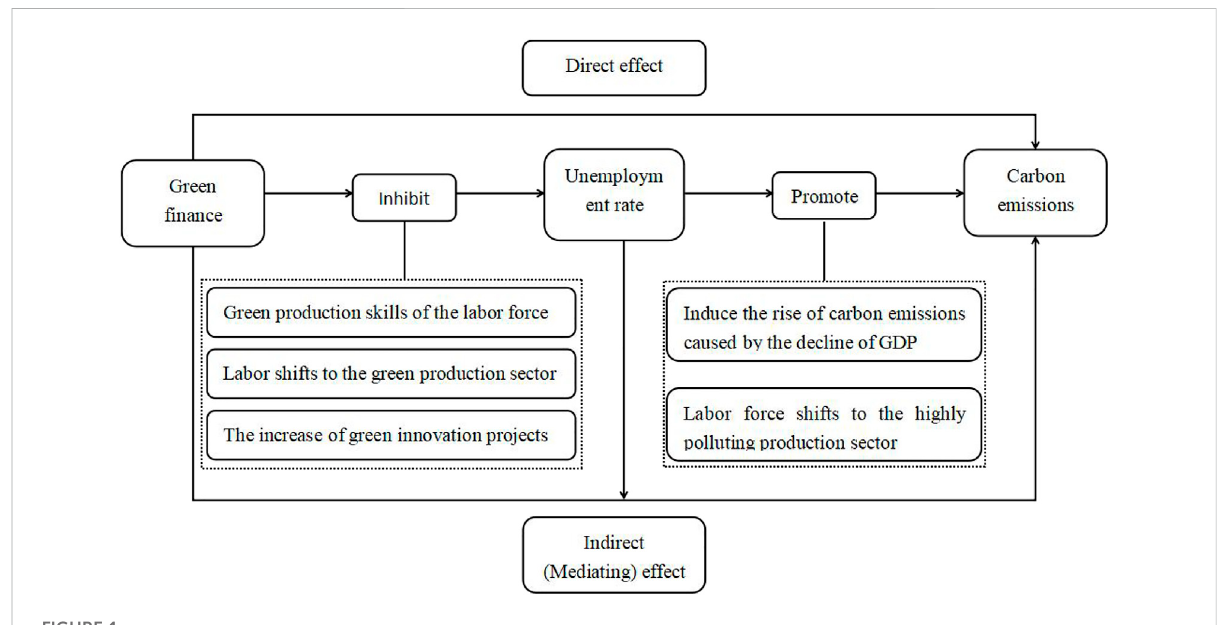
FIGURE 1 Role mechanism